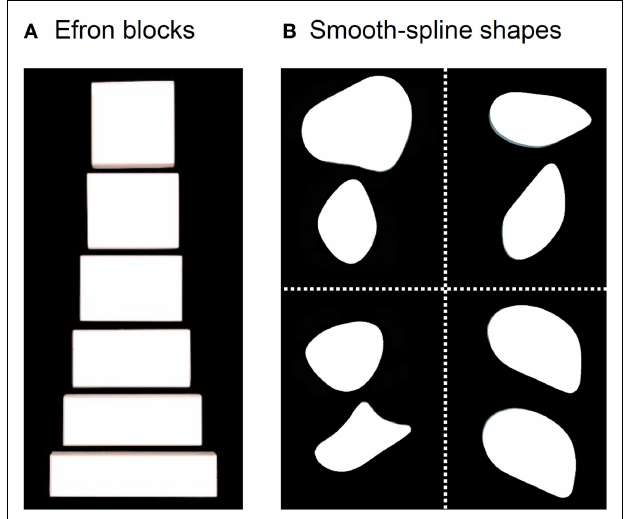
FIGURE 1 | (A) Examples from a set of Efron blocks that, by definition, are matched for surface area, texture, mass, and color, but vary in width and length (1). In the grasping task, DF reached out to pick these objects up across their width. In a typical perceptual task, she is asked to indicate manually the width of the block by adjusting her thumb and index-finger a matching amount or to provide same/different judgments about pairs of these objects. (B) Examples of the pebble-like shapes used in Goodale et al. (10). DF was asked to either (i) reach out to pick up the shapes presented at one of two possible positions one at a time or (ii) give explicit same/different judgments about pairs of shapes when they had different shapes and different orientations (top left), the same shape but different orientations (top right), different shapes but same orientations (bottom left), and same shape and orientation (bottom